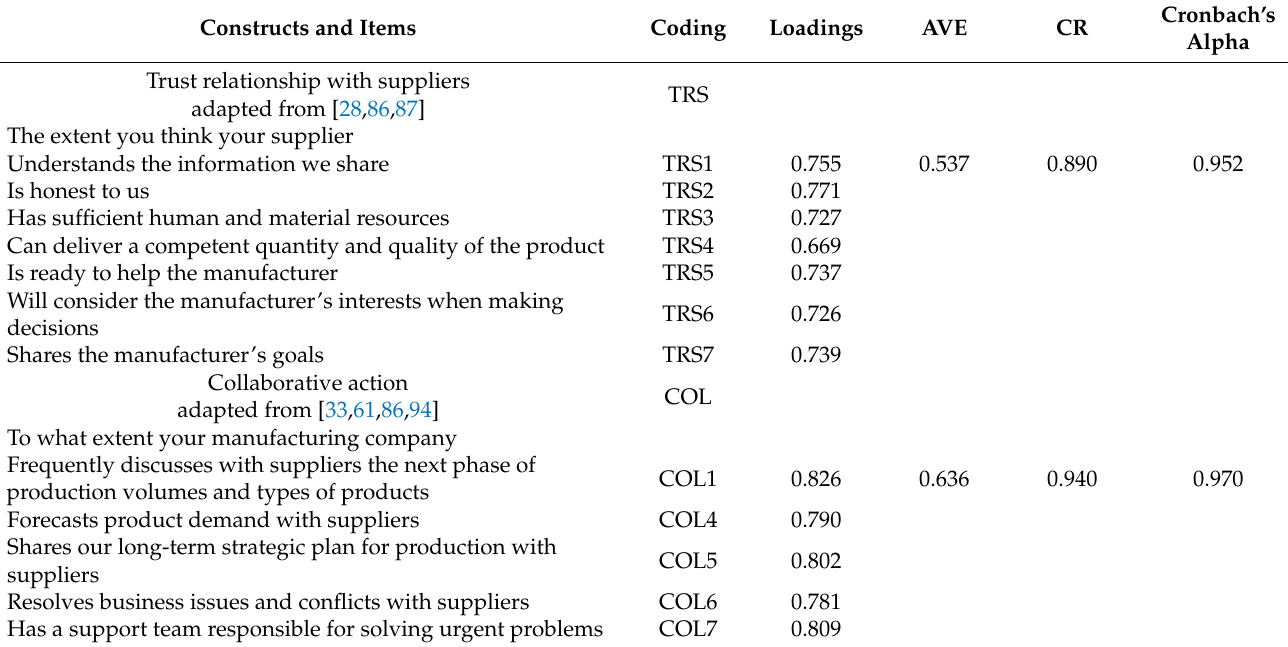
Table 3. The constructs and measurement